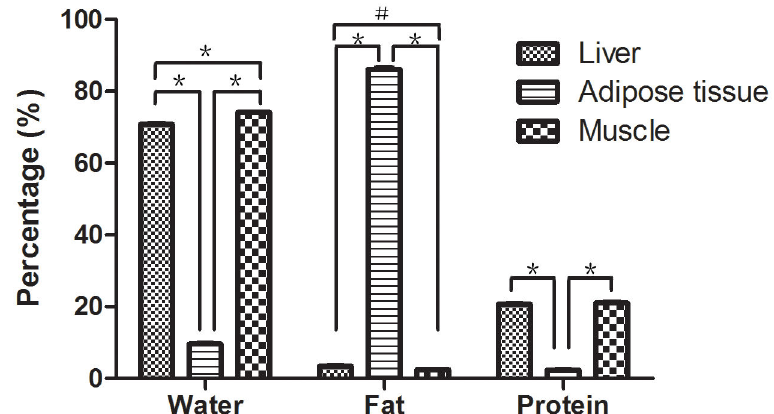
Figure 2. The average percentages of water, fat and protein in liver, muscle and adipose tissue (* P < 0.001; (cid:0) P < 0.05). doi: